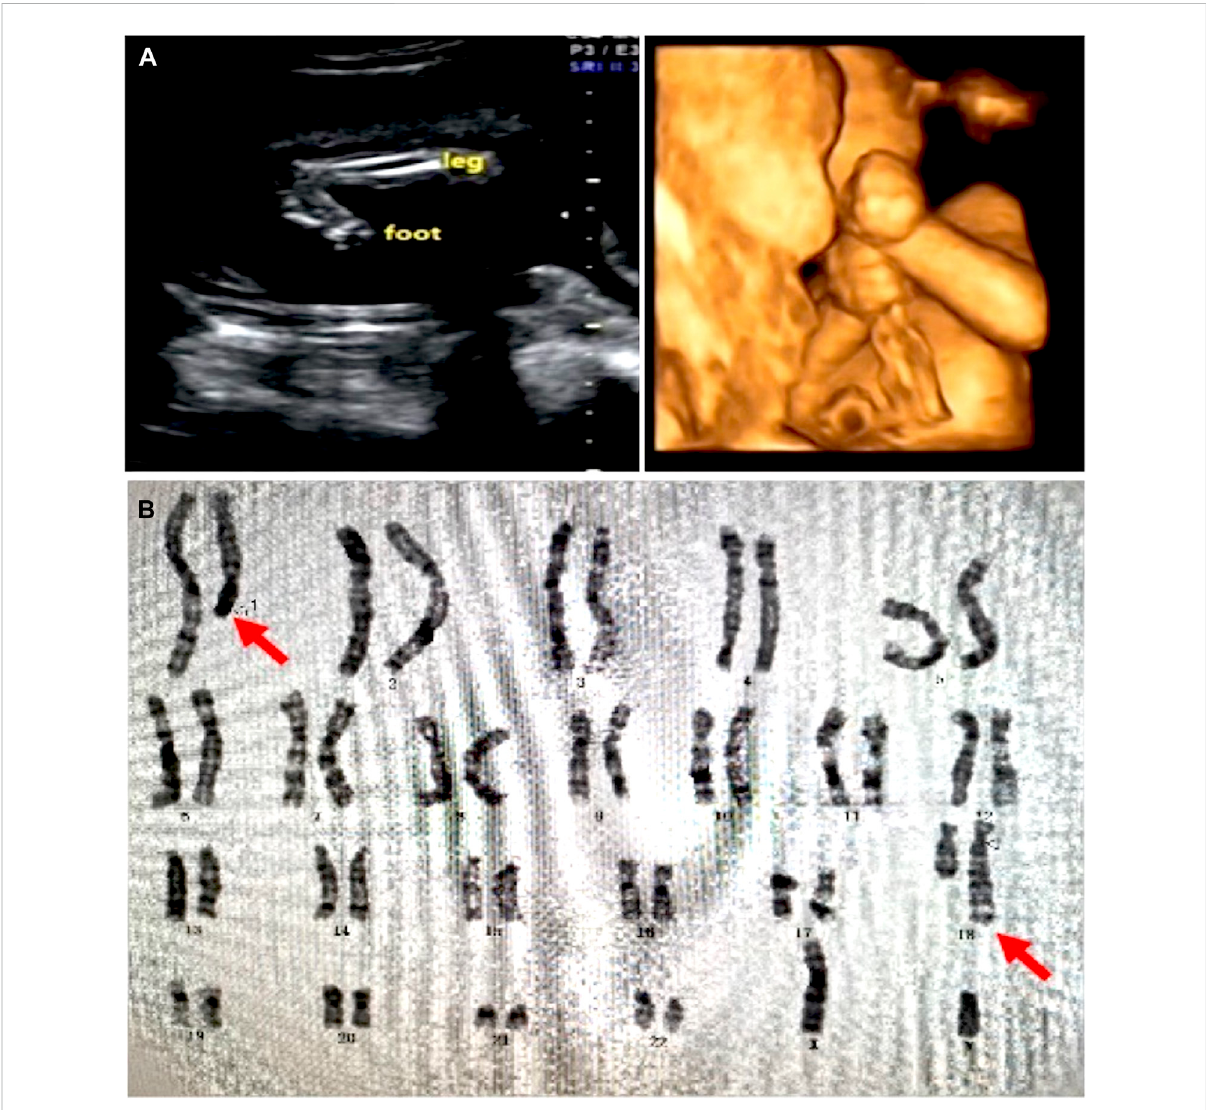
FIGURE 1 Ultrasound and karyotyping results in case 12. (A) Ultrasound showed signi fi cant macrocephaly, bilateral talipes calcaneovalgus, and clenching hand. (B) Karyotyping showed a balanced translocation 46,XN,t(1; 18) (q25; q23)dn. The original report of karyogram was unavailable. Red arrows showed the mutually translocated chromosomal